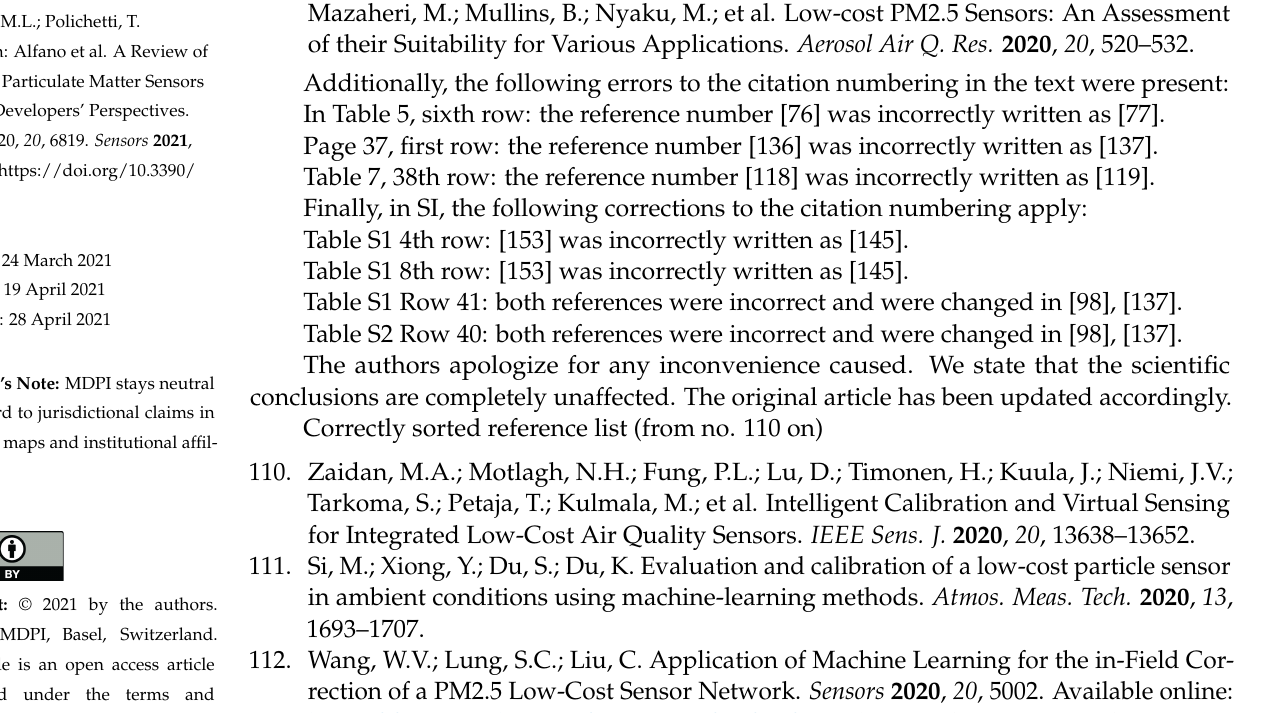
Table S1 4th row: [153] was incorrectly written as [145]. Table S1 8th row: [153] was incorrectly written as [145]. Table S1 Row 41: both references were incorrect and were changed in [98], [137]. Table S2 Row 40: both references were incorrect and were changed in [98],